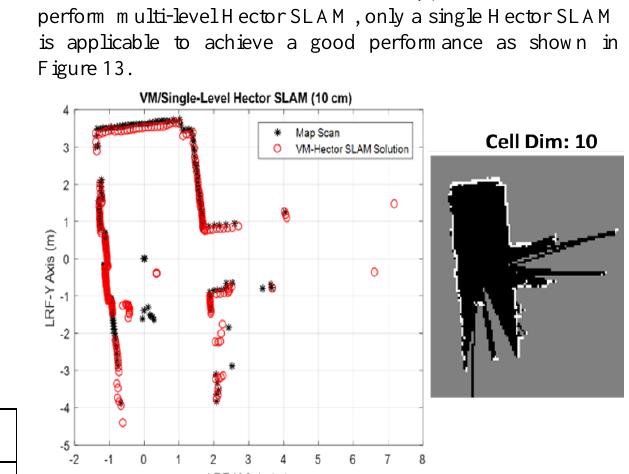
Figure 6. First experiment VM/ single-level Hector SLAM performance (10 cm grid